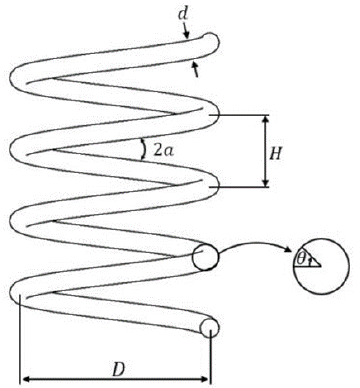
Figure 1. Geometry of a helically coiled pipe.